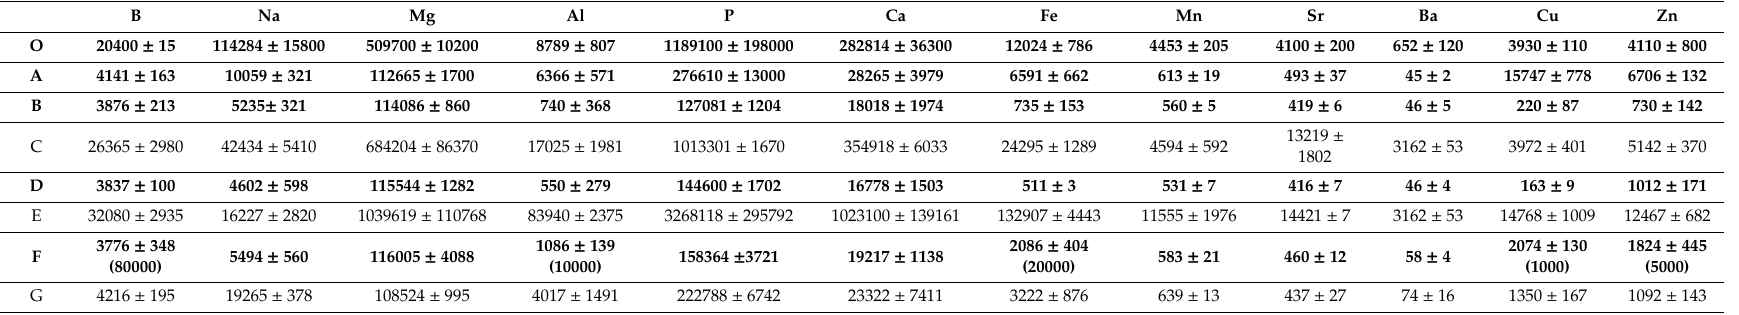
Table 1. Concentrations ( µ g kg − 1 ) found for abundant elements in the di ff erent fractions of the winemaking process without added yeast